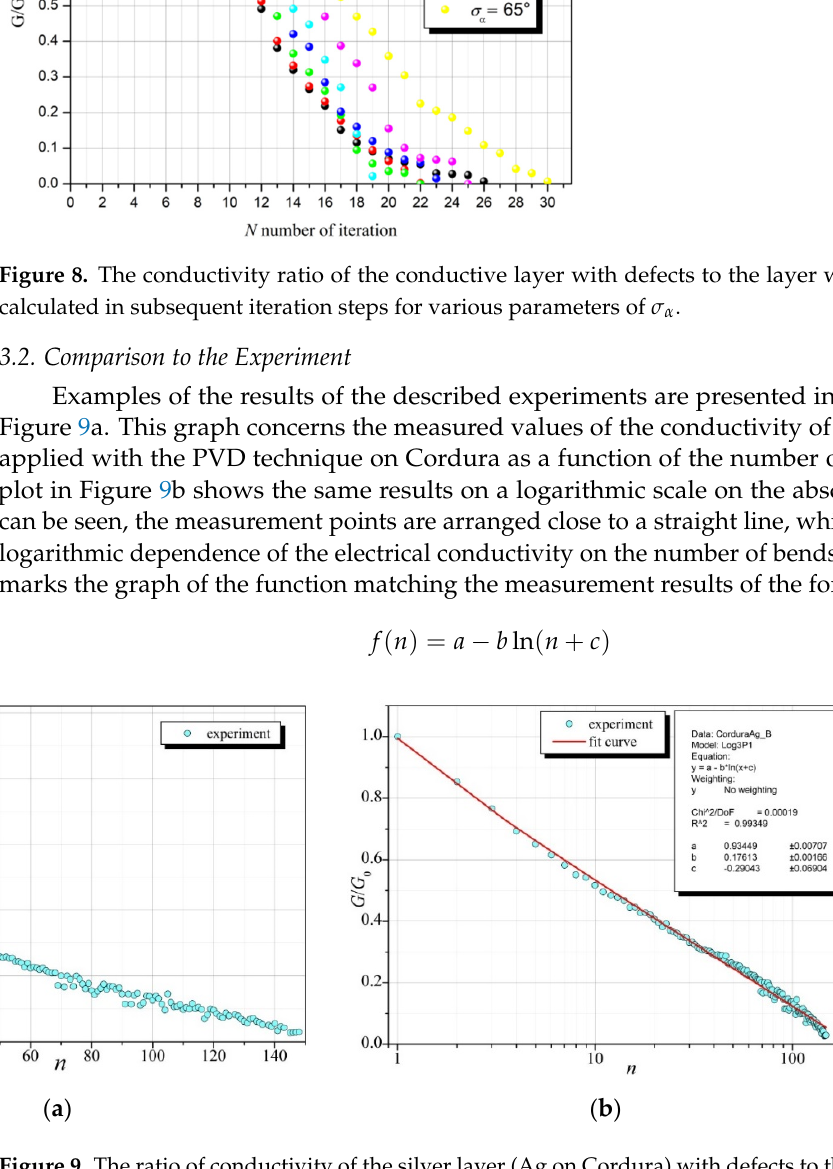
Figure 7. The ratio of the conductivity of the conductive layer with defects to the conductivity of the layer without defects depending on the ratio of the average length of the defect line segments d 0 in relation to the layer width y max . Other simulation parameters are as follows: σ d = 0.2 d 0 , and N = 10.